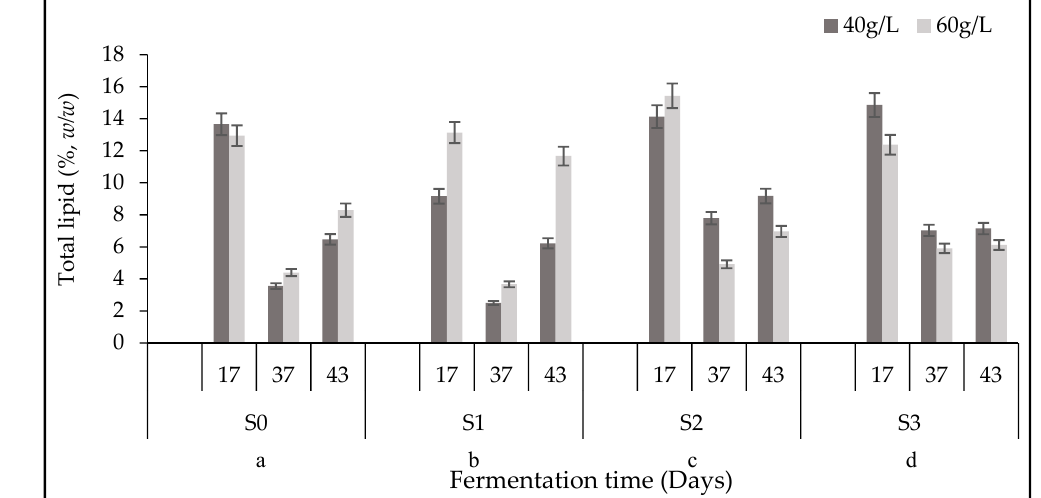
Figure 7. Total lipids in ( A ) absolute (g/L) and ( B ) relative (%, w/w , in dry weight) values during the cultivation of P. pulmonarius in liquid cultures with OMWs containing: (a) 0 g/L phenolic compounds and initial concertation glucose 40 and 60 g/L (S0-G40, S0-G60), (b) 1 g/L phenolic compounds and initial concertation glucose 40 and 60 g/L (S1-G40, S1-G60), (c) 2 g/L phenolic compounds and initial concertation glucose 40 and 60 g/L (S2-G40, S2-G60), (d) 3 g/L phenolic compounds and initial concertation glucose 40 and 60 g/L (S3-G40, S3-G60). Each point is the mean value of at least three independent measurements, SD < 5%.